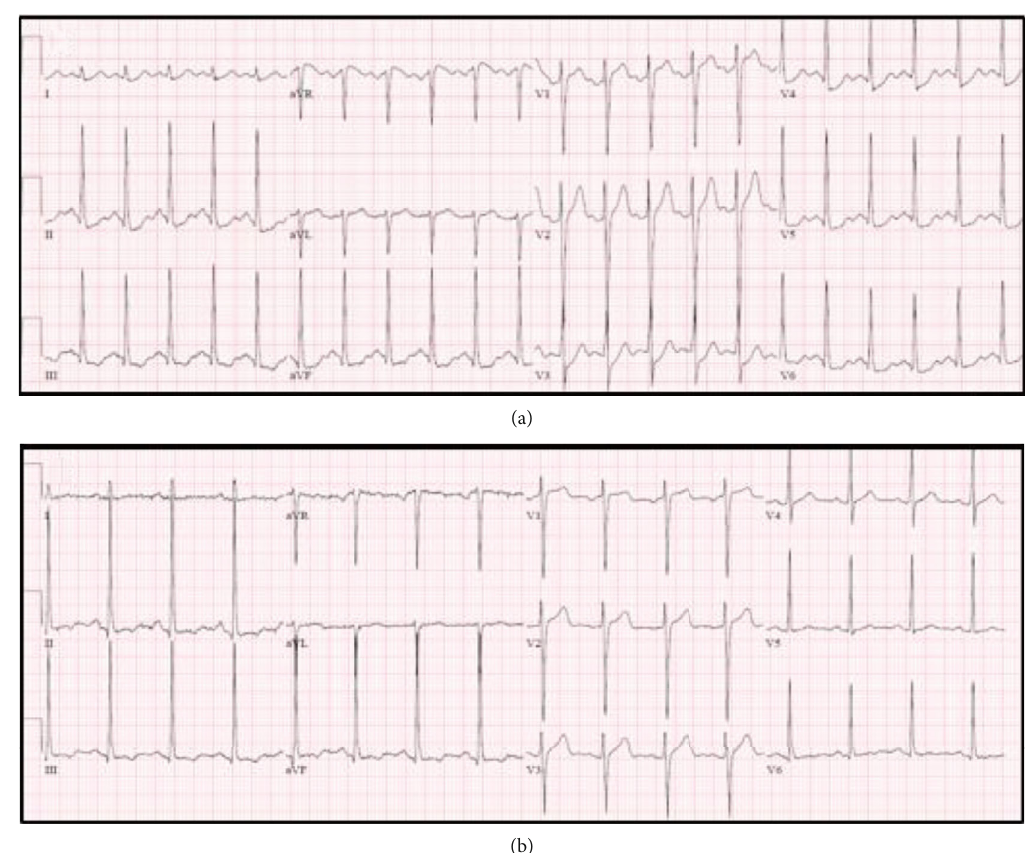
Figure 1: (a) Initial ECG displaying ST-segment elevation in lead aVR and di ff use ST-segment depressions. (b) ECG after aggressive hydration displaying normalization of ischemic